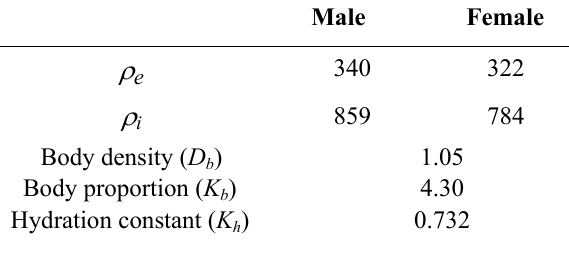
Table II. Proportionality and body resistivity constants used with